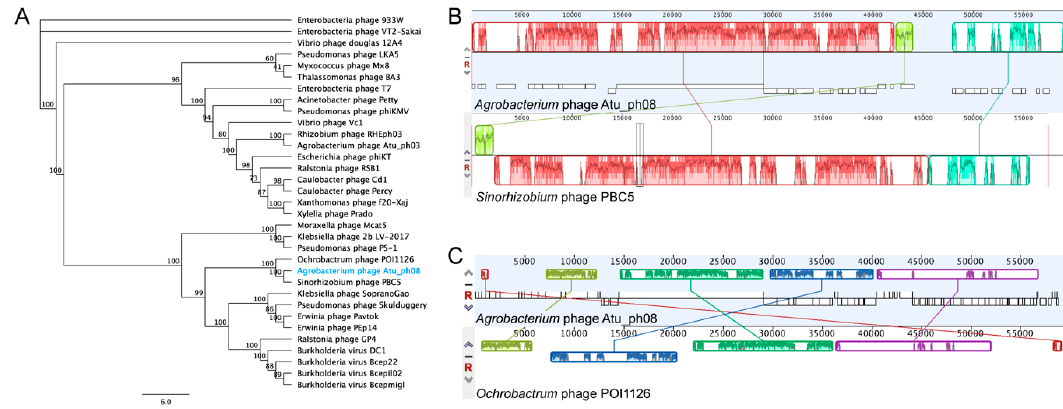
Figure 6. Relatives of Atu_ph08. ( A ) Phylogenetic tree of large terminase protein. Mauve genome alignment of Atu_ph08 with ( B ) Sinorhizobium phage PBC5 and ( C ) Ochrobactrum phage POI1126. 3.11. The Atu_ph08 Genome Encodes a DarB-like Protein, Commonly Found Among PBC5-Like Phages